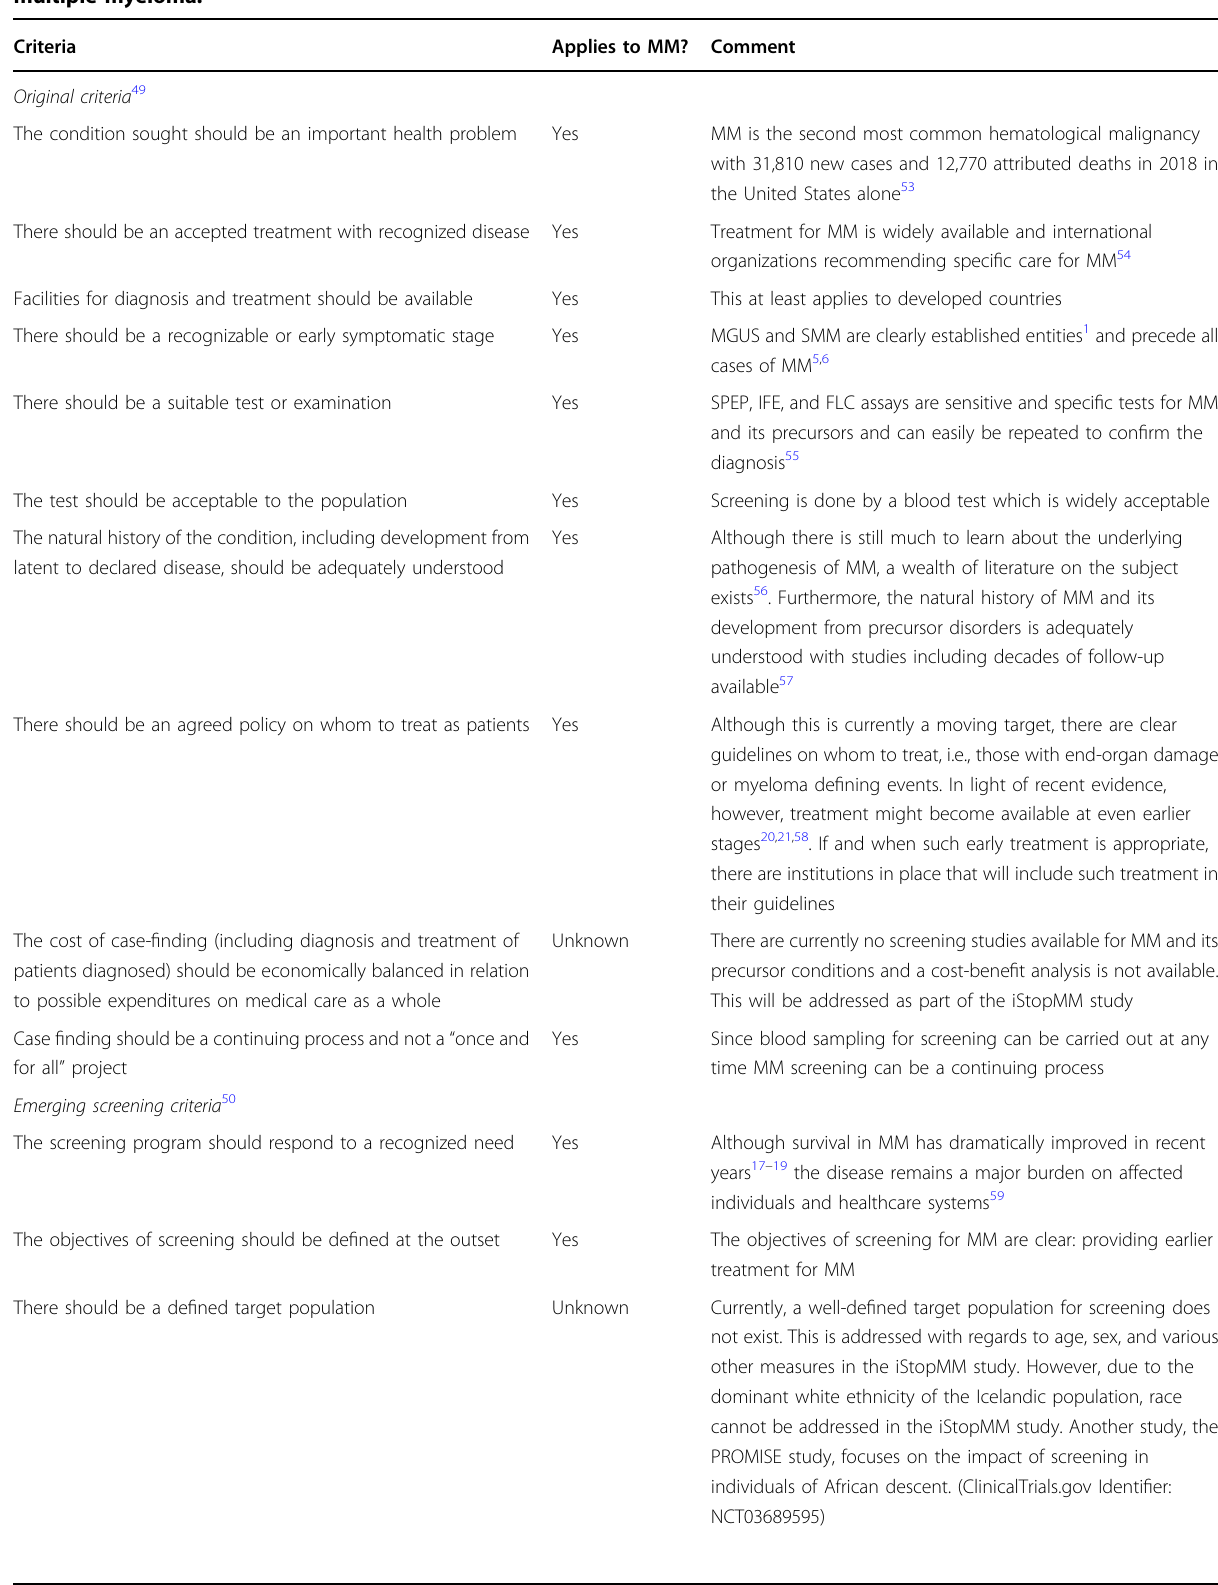
Table 5 Application of the Wilson and Jungner criteria and the additional recently proposed emerging criteria to multiple